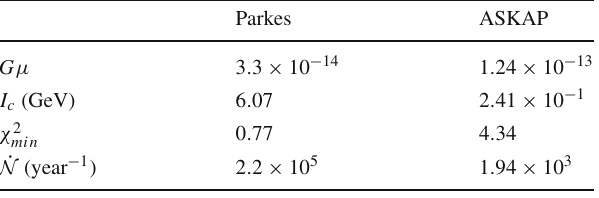
Table 3 Best fits for Parkes and ASKAP with corresponding parameter values, ˙ N per year and χ 2